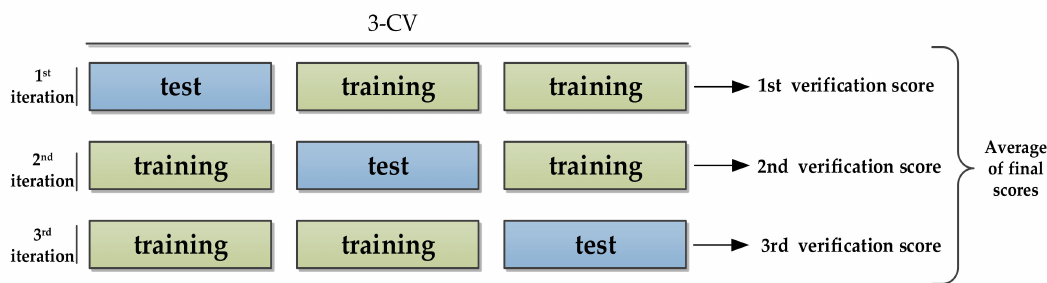
Figure 8. Turning point detection model based on Stacked Denoising Auto-Encoder (SDAE) network.